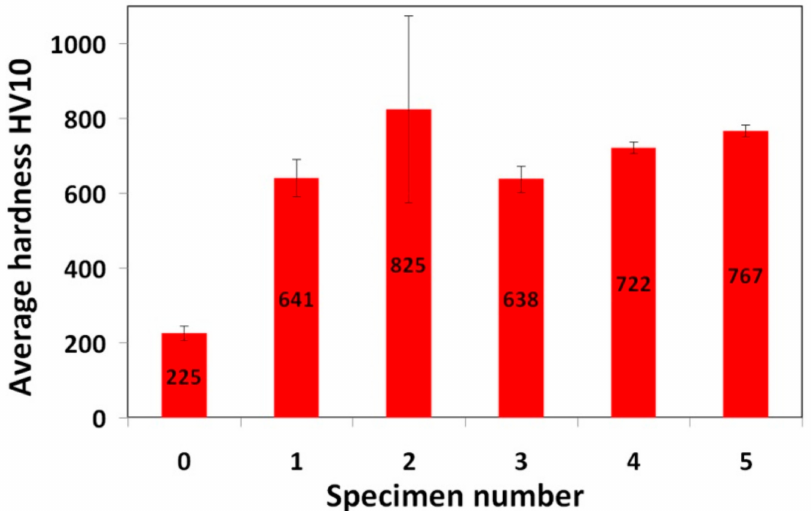
Figure 7. Average surface hardness values of investigated materials: 0—16MnCr5 steel; 1—“E520 RB” hardfacing; 2—“RD 571” hardfacing; 3—“LNM 420FM” hardfacing; 4—“E DUR 600” hardfacing; 5—“Weartrode 62”